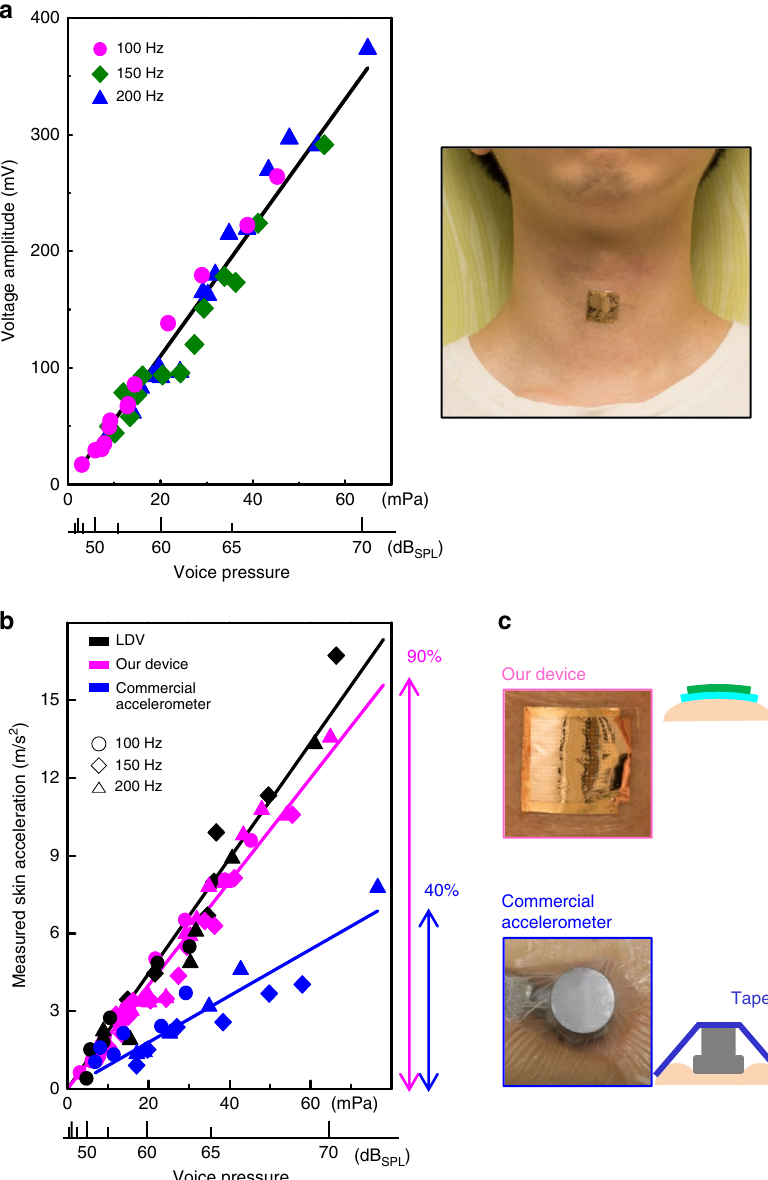
Fig. 4 Voice-recognition performance on human neck skin. a Output voltage amplitude of our device as a function of voice pressure at different frequencies, and photograph of our device attached on the neck skin. b Comparison of measured the skin acceleration between laser Doppler vibrometer (LDV), our device and a commercial accelerometer, when a person spoke at various voice pressure and frequencies. The voice pressure is expressed in pascal (Pa) and decibel of sound pressure level (dB SPL ; 1 Pa = 94 dB SPL ). The percentage values on the right represent the reduced sensitivity due to rough and curved surface of neck skin. c , Photographs and cross-sectional schematic images of our device and the commercial accelerometer attached on the